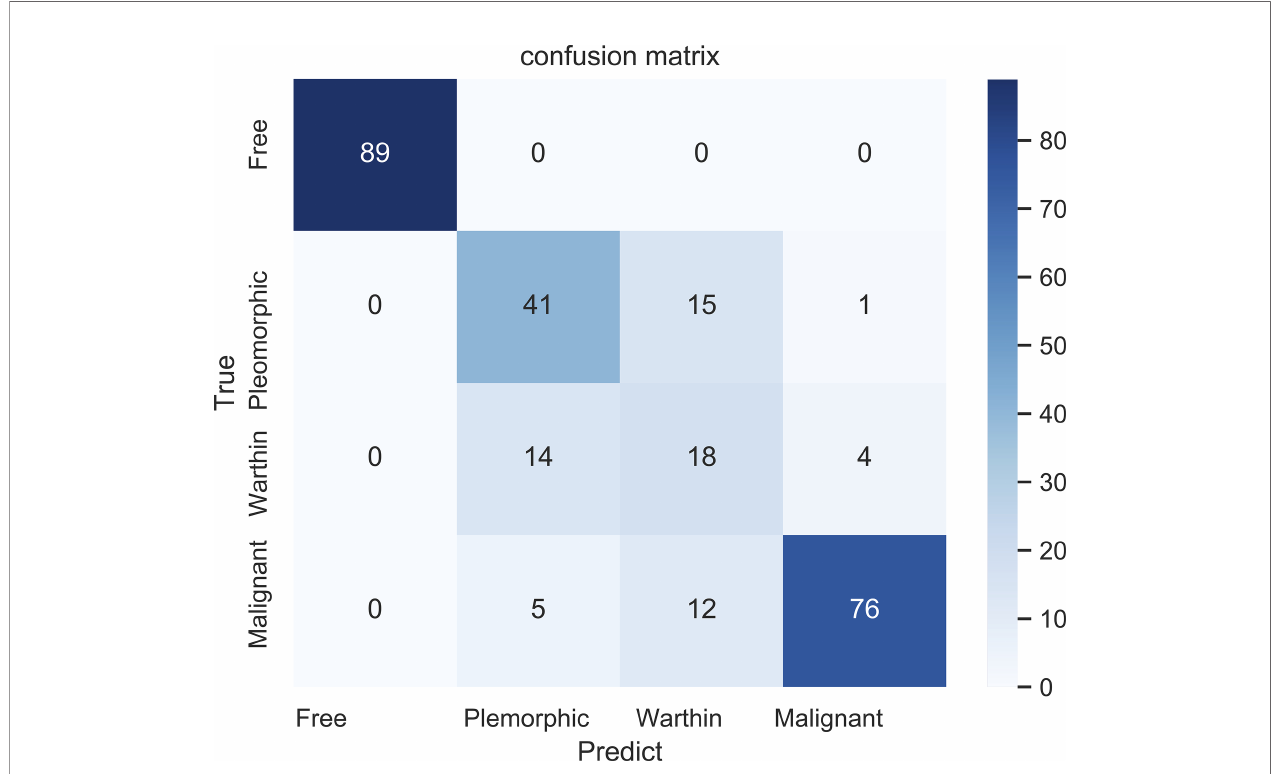
FIGURE 7 | The confusion matrix for the four classi fi cations: free (no tumor), pleomorphic adenoma, Warthin tumor, and malignant tumor.